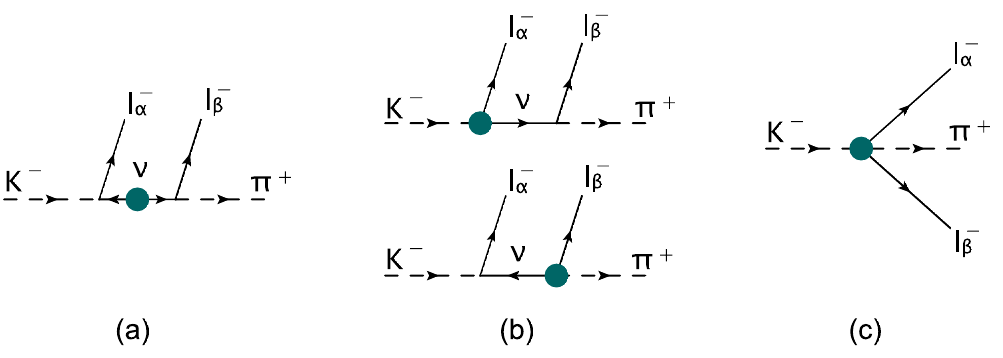
Figure 1 . Generic Feynman diagrams for the decay K (cid:0) ! (cid:25) + l (cid:0) stands for e(cid:11)ective LNV interactions. Diagrams with the two charged leptons crossed are not shown in (a,